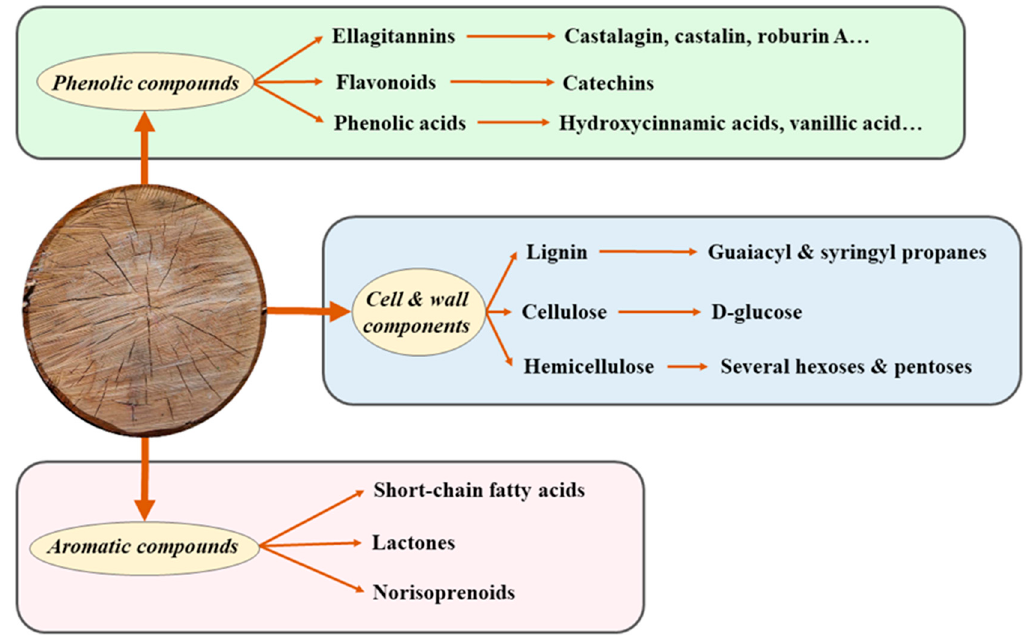
Figure 2. Major compounds of interest released from oak wood during wine aging. These compounds are common to the Quercus genus [54,67].